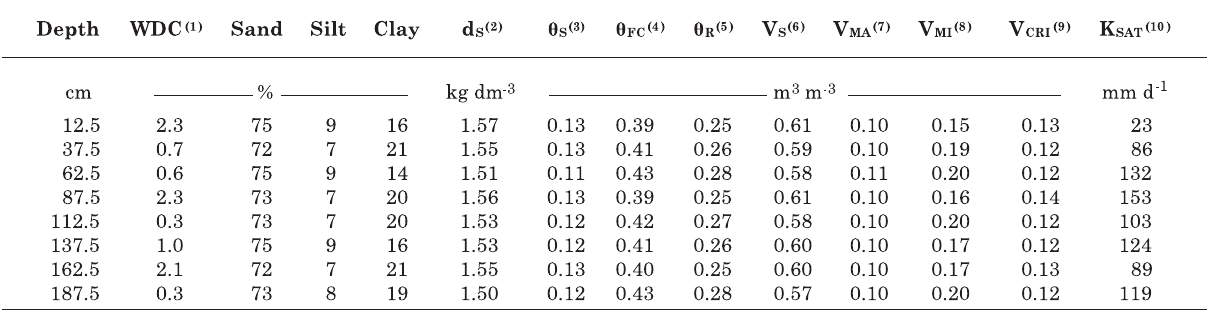
Table 2. Soil physical properties before experiment from 0 to 200 cm soil